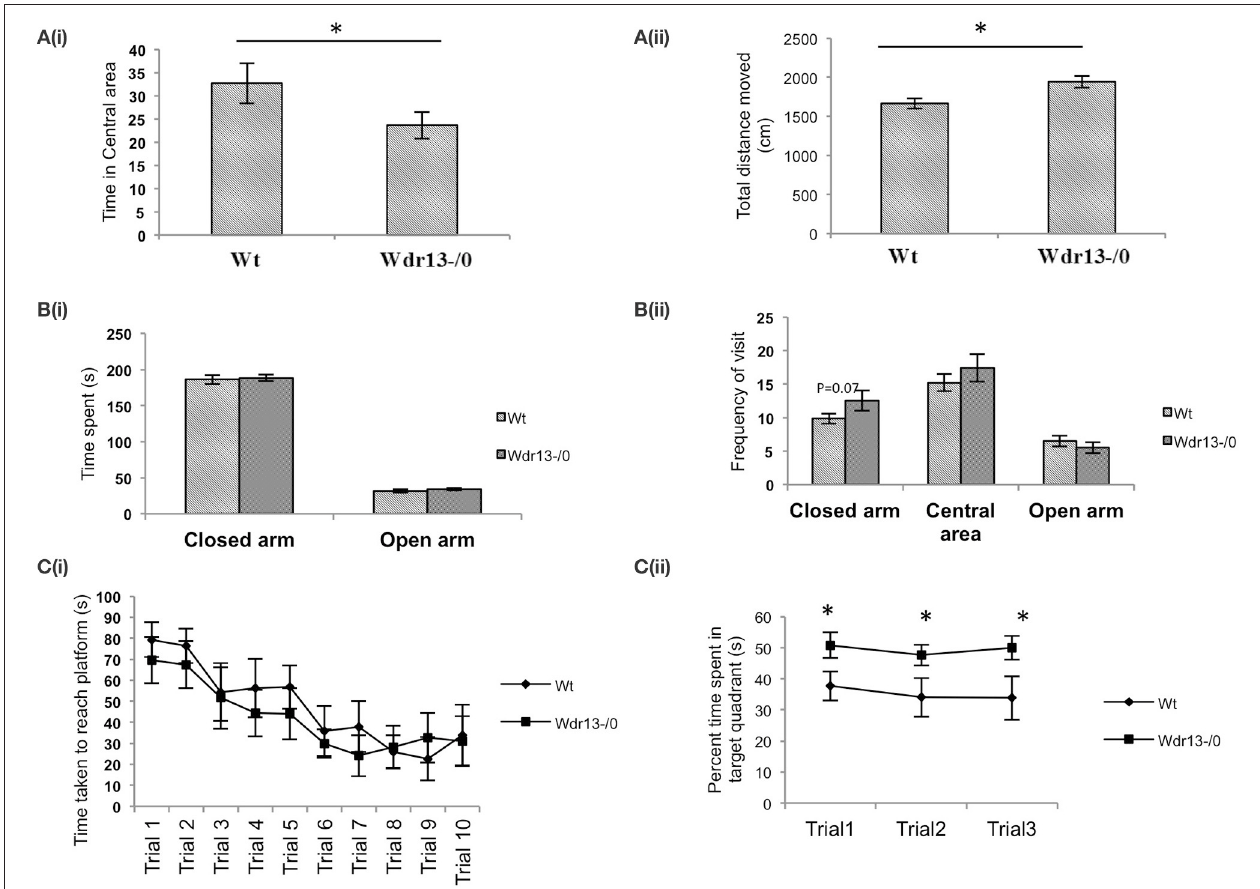
FIGURE 5 | Behavioral tests of Wdr13 − / 0 and wild-type mice in C57Bl/6J background at 2 months of age. (A) Open Field Test. (i) Wdr13 − / 0 mice spent significantly ( T -test; p < 0.05) less time in the central area of the open field as compared to wild-type mice. (ii) Wdr13 − / 0 mice moved significantly ( T -test; p < 0.05) more distance in the open field arena than the wild-type mice ( n = 16; Cohort 1 ′ ). (B) Elevated plus maze. (i) There was no significant difference ( T -test; p > 0.05) between Wdr13 − / 0 and wild-type mice in time spent in closed arm and central area (ii) . Wdr13 − / 0 mice showed marginally increased frequency to visit the closed arm than the wild-type mice. However, this difference was not significant statistically ( T -test; p = 0.06). No significant differences ( T -test; p > 0.05) were observed between the wild-type and Wdr13 − / 0 mice in the frequency of visit to the central area or open arm ( n = 8; Cohort 2 ′ ). (C) Morris Water Learning and Memory test. (i) There was no significant difference (ANOVA, p > 0.05) between Wdr13 − / 0 and wild-type mice in the latency to reach the platform during the learning trials (ii) . Wdr13 − / 0 mice spent significantly [ANOVA, F (1 , 36) = 10.24; p < 0.005] more time in the target quadrant on repeated probe trials (extinction trials) as compared to the wild-type mice ( n = 8; Cohort 2 ′ ). Data represented as ± SEM. Wt, wild-type; Wdr13 − / 0 , Wdr13 knockout mice. * p <